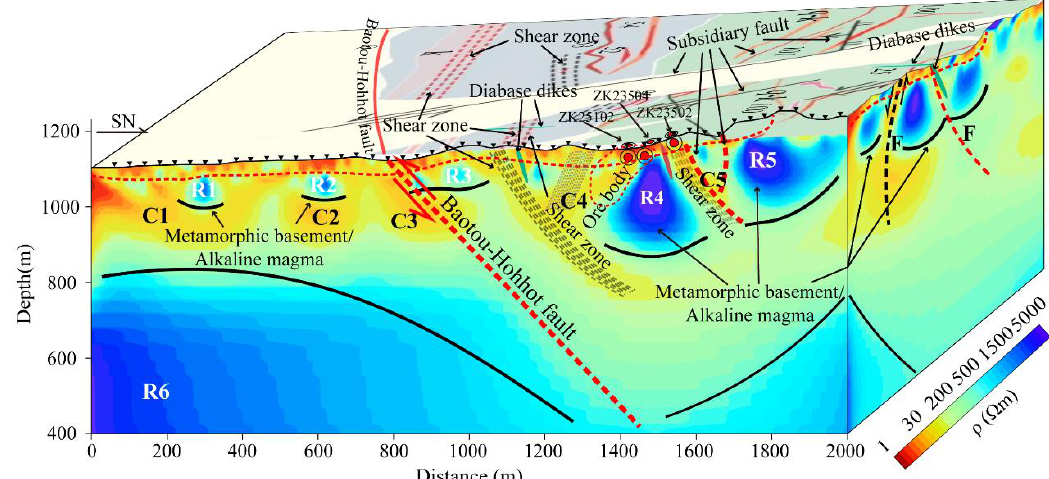
Figure 6. The schematic plot of metallogenic model of the Hadamengou gold deposit inferred by resistivity models combined with SIP sounding. The geological bodies on the geological map correspond well with their position inferred from the resistivity model, such as the Baotou – Hohhot fault, subsidiary fault, shear zone, and diabase vein, etc.